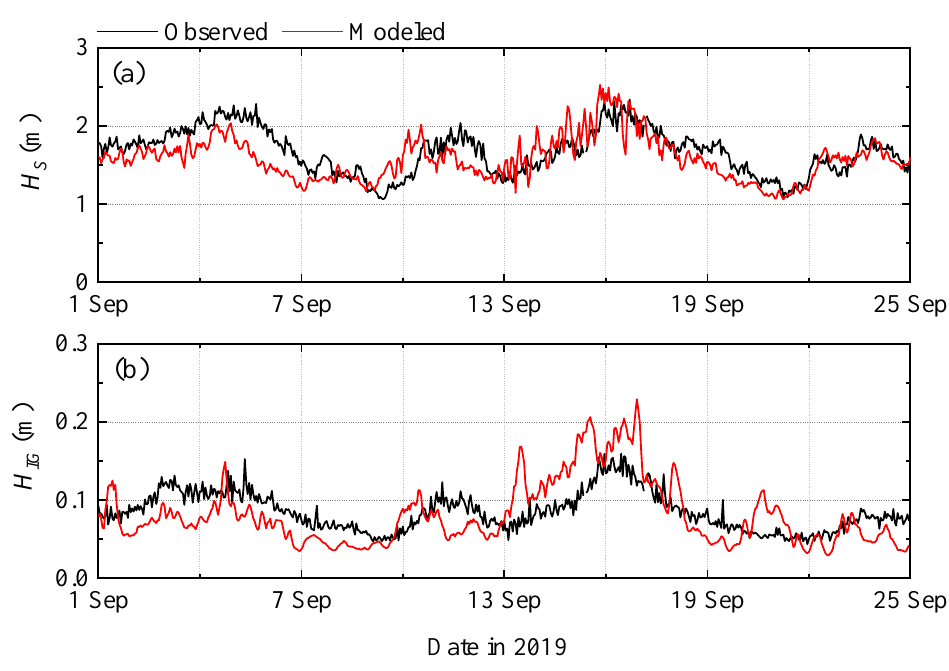
Figure 6. Modeled (red) and observed (black) wave heights 1–25 September 2019, at the location of sensor G2: ( a ) significant wave height H S and ( b ) significant IG wave height H IG .